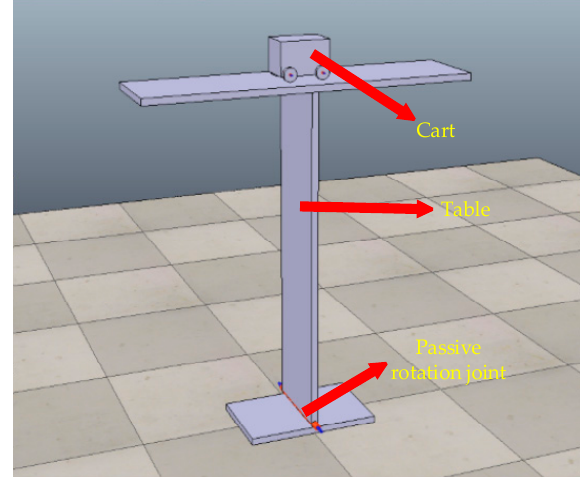
Figure 2. Cart – table model in the simulation. Figure 2. Cart–table model in the